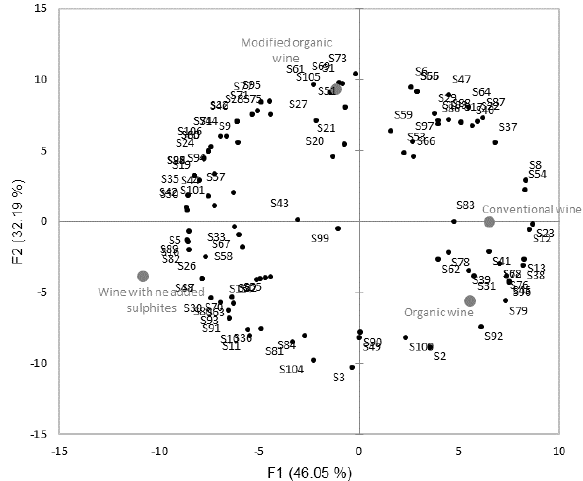
Figure 3. Principal component analysis in the WTP of consumers at the sensory stage. The variables correspond to the judgements of 106 subjects and observations for the four wines presented (78% of variance represented in the first two factors).